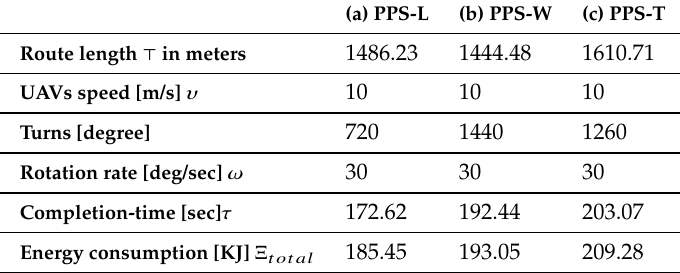
Table 8. Our CPP using our PPS-L partition method vs. PPS-W partition method vs. PPS-T partition method.